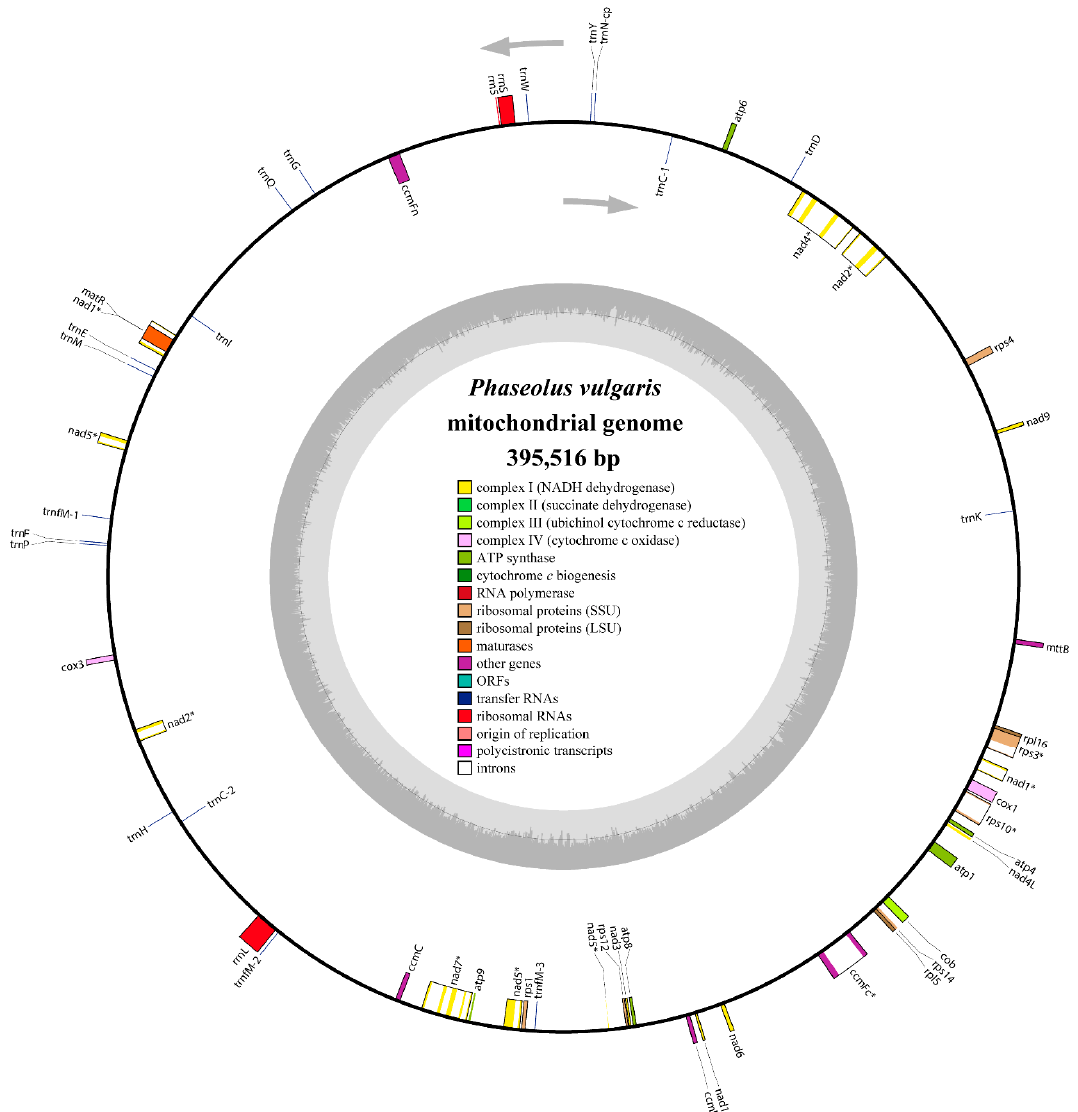
Figure 2. Circular map of the P. vulgaris mitogenome. Genes shown on the outside of the circle are transcribed clockwise, whereas genes on the inside are transcribed counterclockwise. GC content is represented on the inner circle by the dark gray plot. The asterisks besides genes denote intron-containing genes.